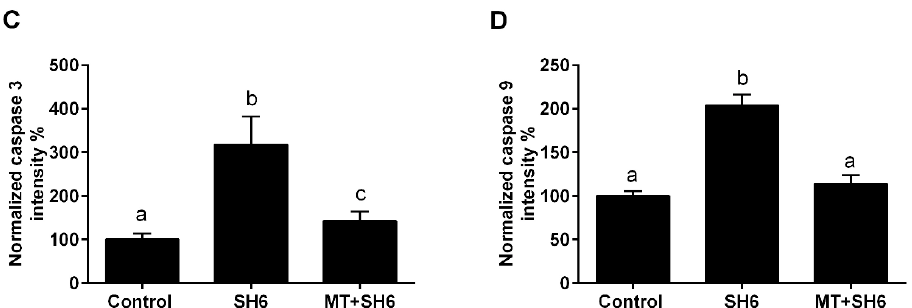
Figure 7. Immunofluorescence on matured oocytes showing caspase 3 ( A ) and caspase 9 ( B ) expression; ( C , D ) Mean values of the integrated optimal densities of caspase 3 and caspase 9, respectively. Superscripts with different letters indicate statistical significance ( p < 0.05). Original magnification 100×.